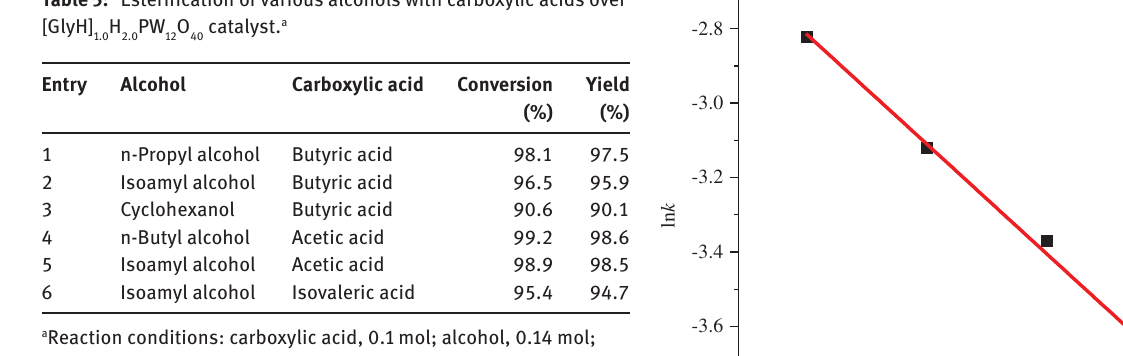
Figure 3: Plot of ln( C acid and butanol.